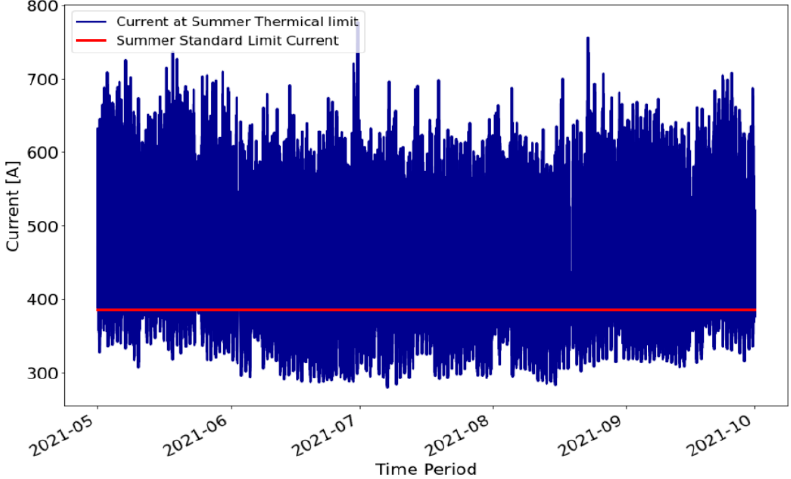
Figure 10. Current trend for summer period of a generic HV Line.